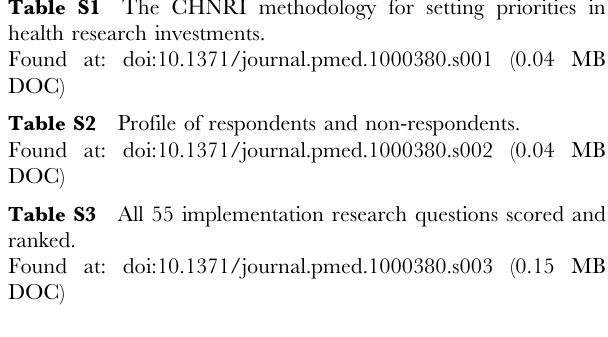
Table S1 The CHNRI methodology for setting priorities in health research investments.